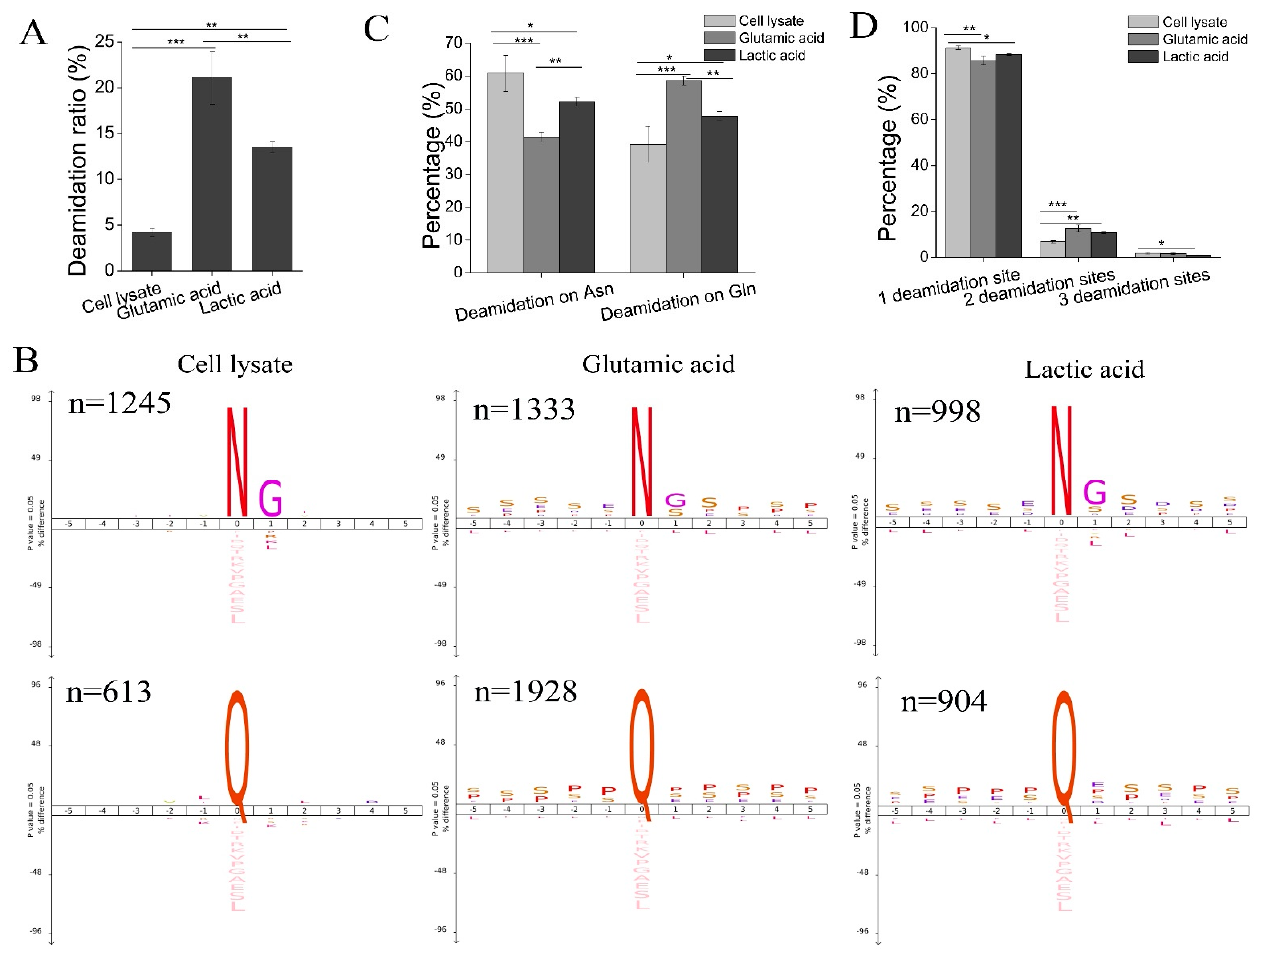
Figure 5. Deamidation of phosphopeptides. ( A ) The deamidation ratio (measured by the ratio of deamidated (phospho)peptides to all (phospho)peptides identified) in peptides identified from cell lysate, and phosphopeptides identified with the glutamic acid method and the lactic acid method. Bars show mean ± SD of the three replicates; ** p < 0.01, *** p < 0.001 (one-way ANOVA with LSD post hoc test). ( B ) The iceLogo sequence motif analysis of residues flanking deamidation sites in peptides identified from cell lysate (left), and phosphopeptides identified from the glutamic acid method (middle) and the lactic acid method (right) ( p < 0.05). The height of amino acid letters corresponds to the percentage. N represents amino acid asparagine; Q represents amino acid glutamine; G represents amino acid glycine; S represents amino acid serine. ( C ) The percentage of deamidation sites (deamidation on Asn or Gln) in peptides identified from cell lysate, and phosphopeptides identified from the glutamic acid method and the lactic acid method. Bars show mean ± SD of the three replicates; * p < 0.05, ** p < 0.01, *** p < 0.001 (one-way ANOVA with LSD post hoc test). ( D ) The number of deamidation sites in peptides identified from cell lysate, and phosphopeptides identified with the glutamic acid method and the lactic acid method. Bars show mean ± SD of the three replicates; * p < 0.05, ** p < 0.01, *** p < 0.001 (one-way ANOVA with LSD post hoc